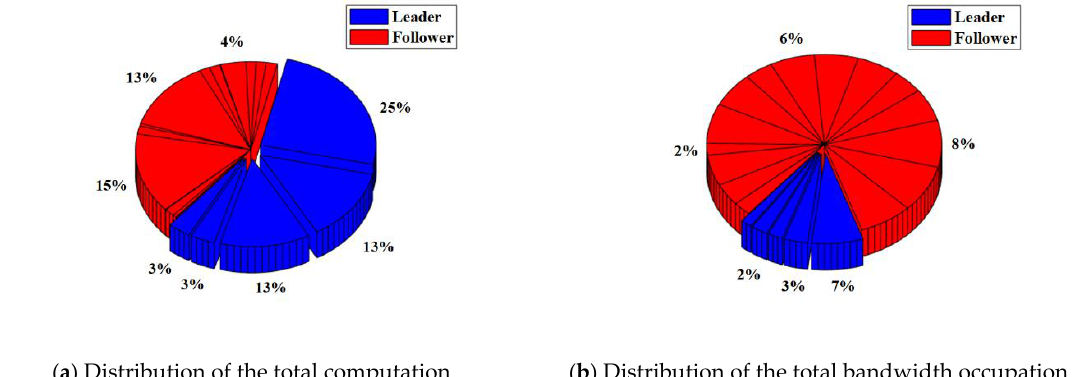
Figure 15. Resource occupation of the DPOS algorithm with malicious nodes.